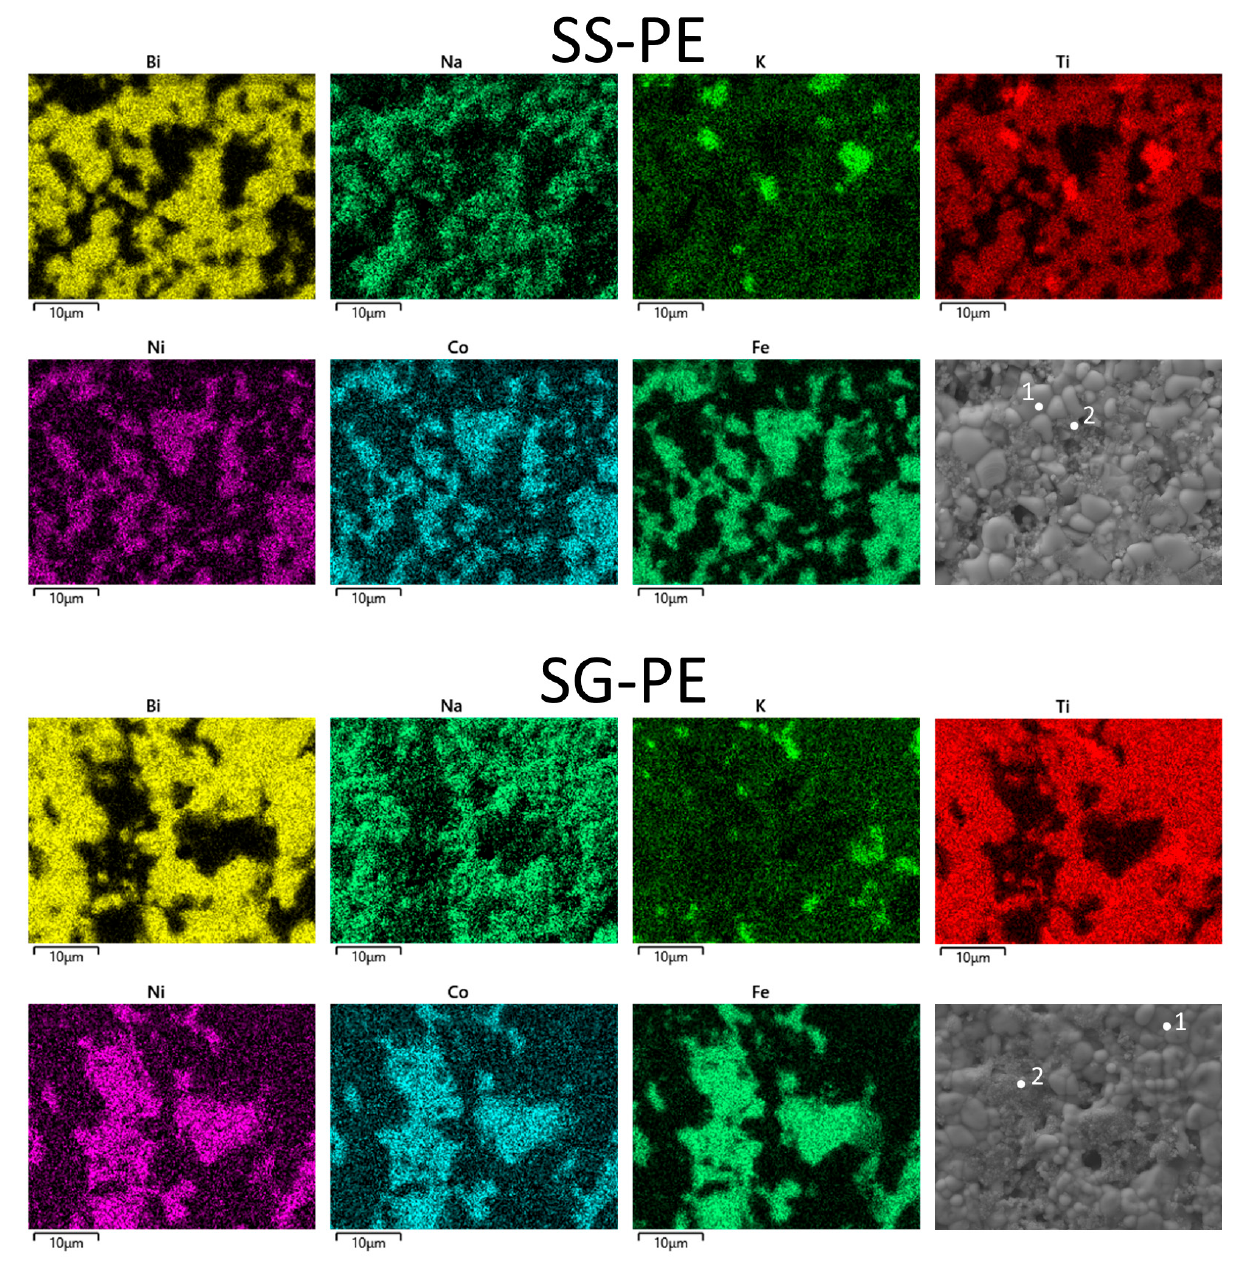
Figure 4. EDS mapping of the different elements corresponding to the 70BNKT-30NCF composites. Points 1 and 2 indicate the places where the atomic content was analyzed. Table 3. Apparent, and theoretical densities, and densification degree values of BNKT-NCF (SS-PE and SG-PE)